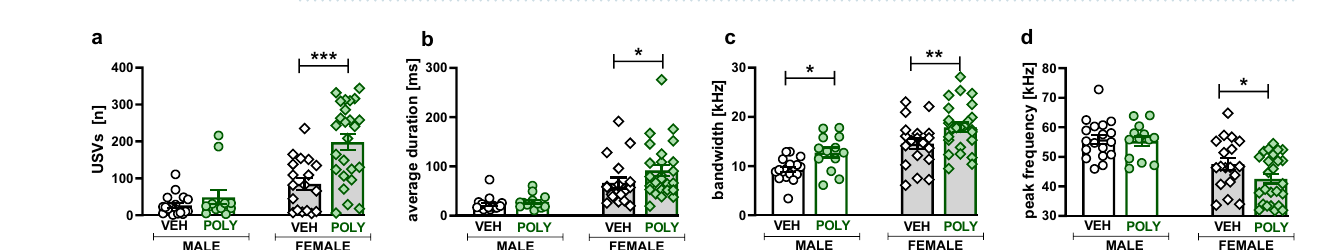
Figure 6. Tickling-induced vocalizations: total USV emission. Poly(I:C) exposure increased the total number ( a ), average duration (b), and bandwidth (c) but decreased the peak frequency ( d ) of emitted calls. Data are presented as a mean ± SEM. Symbols: *p < 0.05, **p < 0.01, ***p < 0.001, a significant difference between vehicle- and poly(I:C)-exposed rats within the given sex (planned